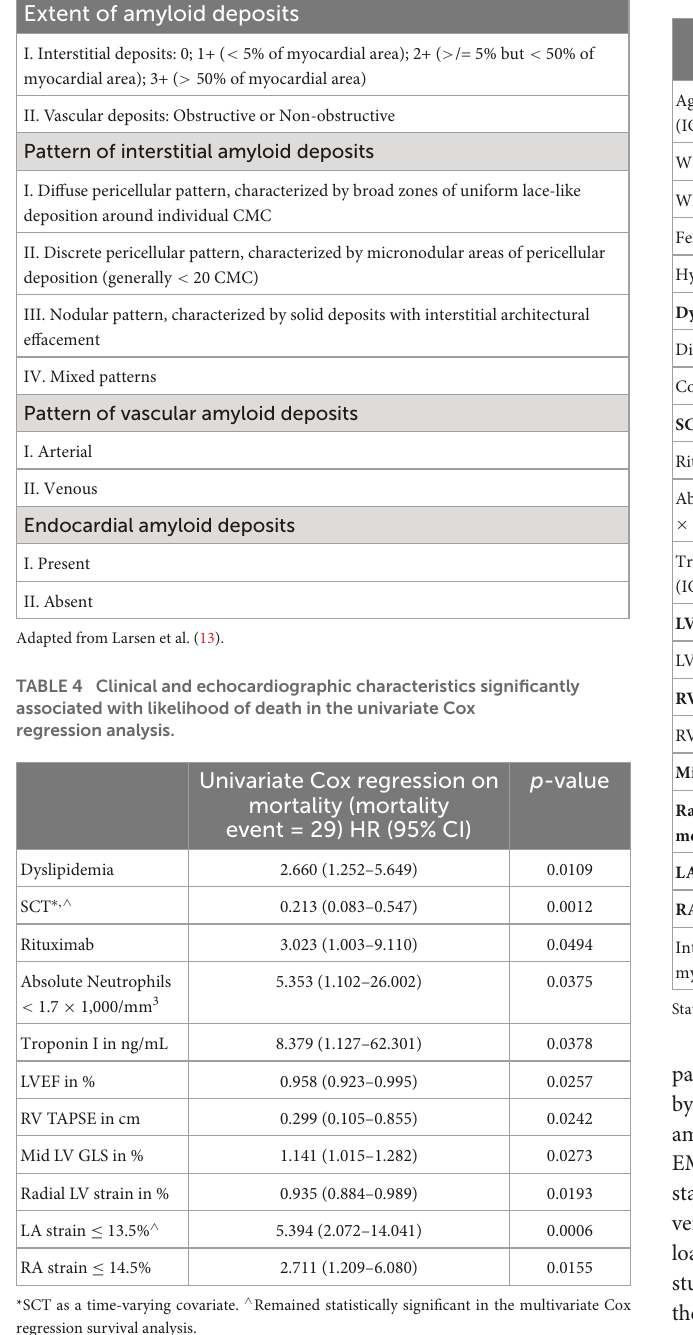
TABLE 5 Comparison of demographic, clinical, echocardiographic and histopathology characteristics of patients with cardiac AL amyloidosis who survived vs those who died during follow